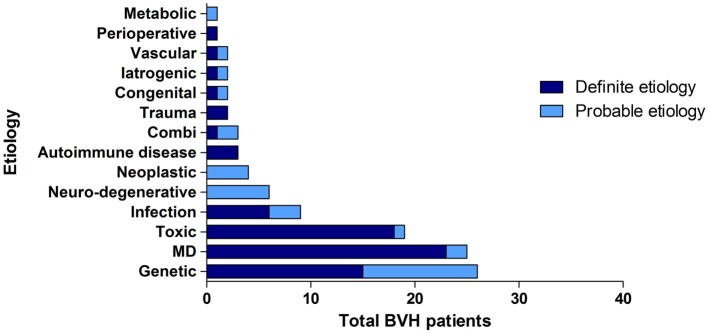
Distribution of etiologies in the BVH group, divided into main groups of etiology and certainty of the etiology.